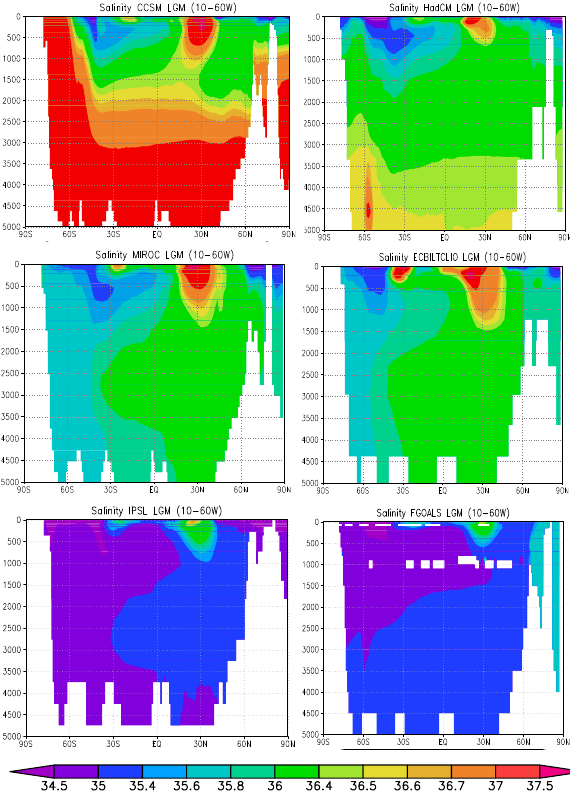
Figure 1 Meridional section of zonal mean salinity in Atlantic Ocean for six Fig. 1. Meridional section of zonal mean salinity in Atlantic PMIP2 models (CCSM3 (Otto-Bliesner et al., 2006) HadCM3M2 (Gordon Ocean for six PMIP2 models (CCSM3 (Otto-Bliesner et al., 2007) HadCM3M2 (Gordon et al., 2000), MIROC 3.2 (K-1-Model- et al., 2000), MIROC 3.2 (K-1-Model-Developers, 2004), ECBilt-CLIO (de Developers, 2004), ECBilt-CLIO (de Vries and Weber, 2005), FGOALS-1.0g (Yu et al., 2002, 2004) and IPSL-CM4-V1-MR (Marti et al., 2005)). The stratification in CCSM3 and HadCM3M2 is comparable with reconstruction (Otto-Bliesner et al., 2007), while the ocean structure in MIROC 3.2, ECBilt-CLIO, FGOALS- 1.0g and IPSL-CM4-V1-MR is more like the present-day, with the saltiest deep-water mass in the North Atlantic. According to their salinity structure, one can divide the PMIP2 models into two main classes, which are related to a highly stratified ocean, but weaker AMOC (i.e. CCSM3 and HadCM, as our quasi-equilibrium ocean state) and weaker stratified, but stronger AMOC (transient ocean